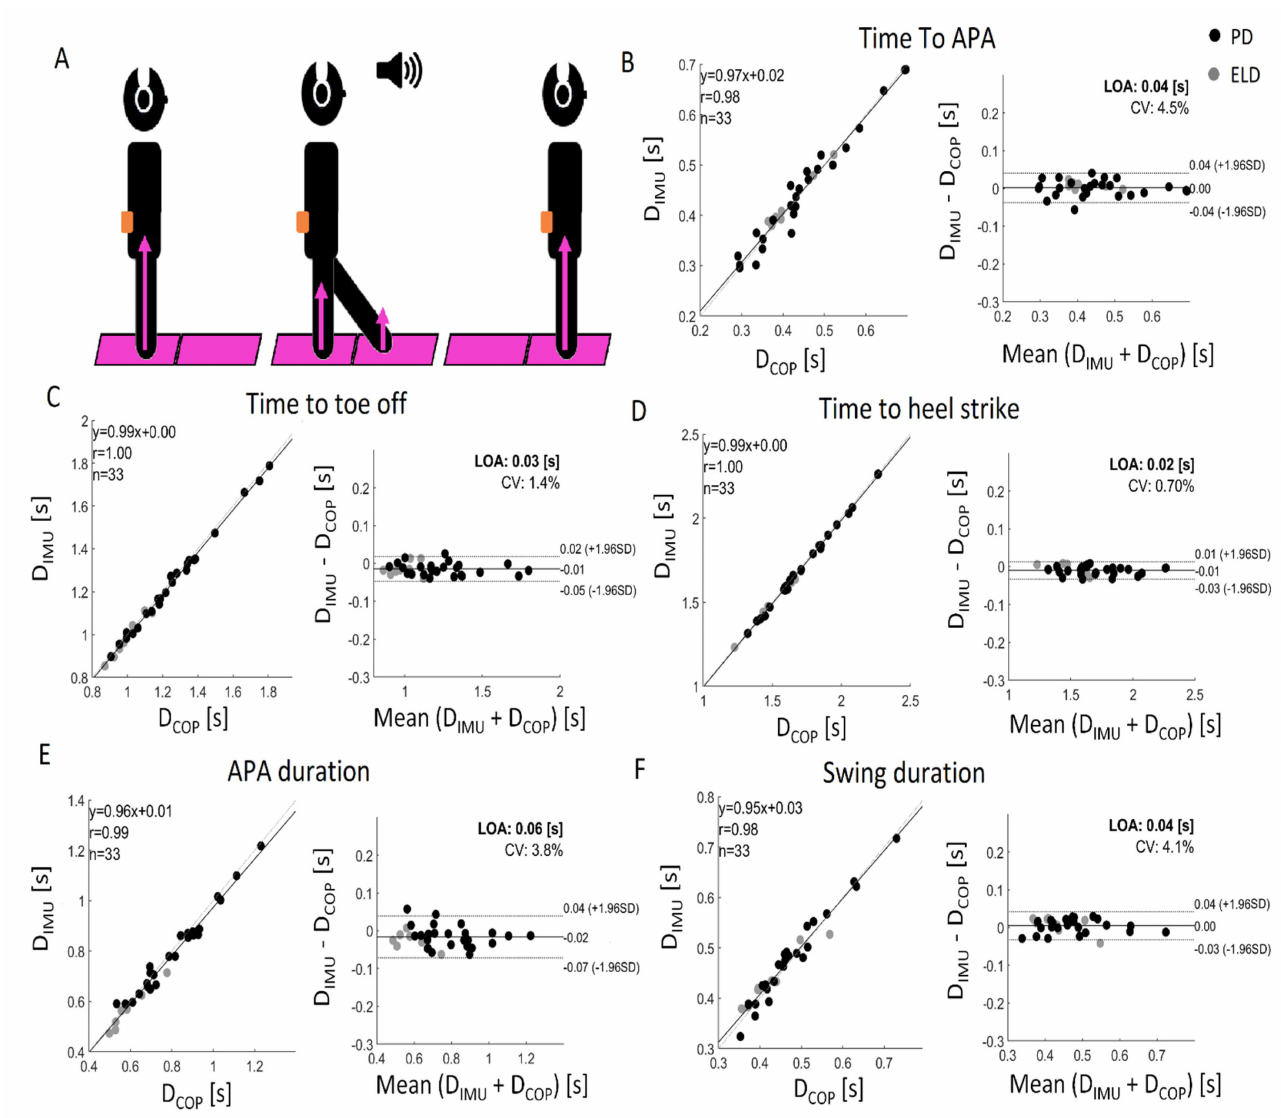
Figure 2. A schematic representation of the experimental paradigm, where the subjects stood on the first platform and took a step forward on the second platform when the stimulus arrived in the headphone ( A ). Bland–Altman plots of APA measures are reported from ( B – F ). PD persons with Parkinson’s disease; ELD